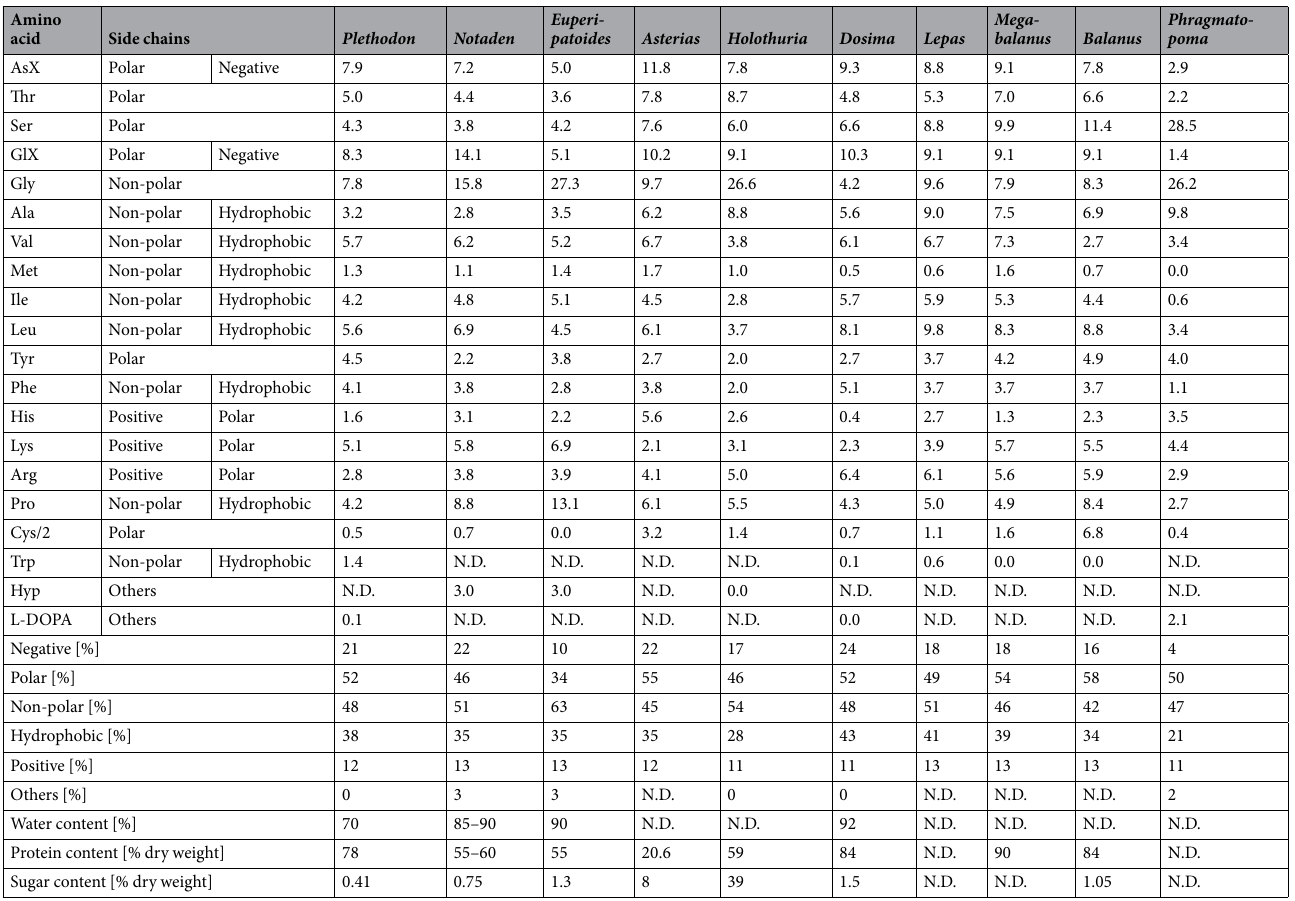
Table 1. Amino acid composition (values in residues per hundred) of the Plethodon shermani secretions (present study) with previous data given for Notaden bennetti 5, 35 , Euperipatoides kanangrensis 36 , Asterias rubens 64 and Holothuria forskali 39 , Dosima fascicularis 37 and Lepas anatifera 43 , Megabalanus rosa 42 and Balanus